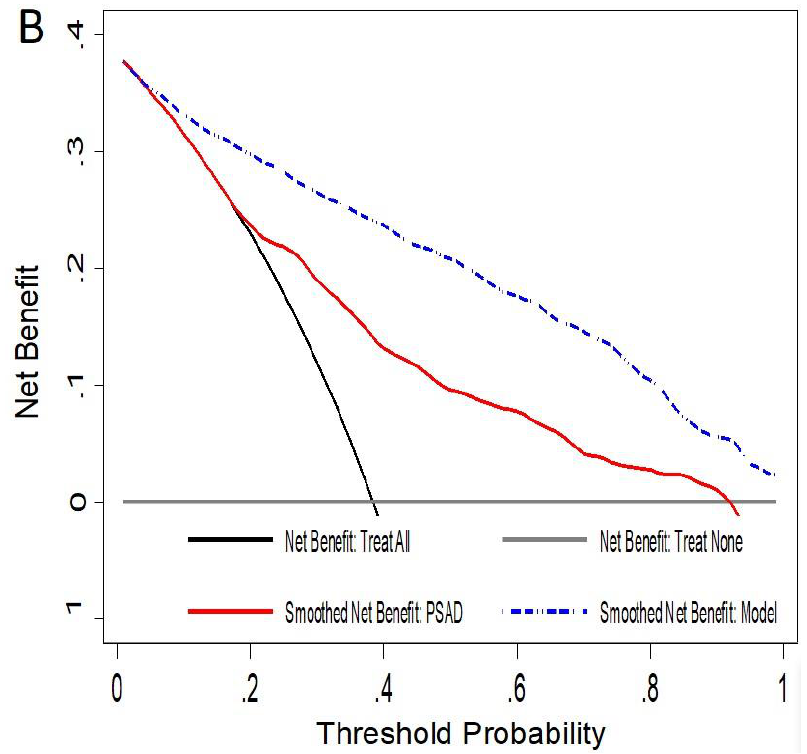
Figure 1. The ROC curves and AUCs show the efficacy of mPSAD (PSAD in the graphic) and MRI- PMbdex (model in the graphic) in detecting csPCa ( A ). The DCAs show the net benefit of mPSAD and MRI-PMbdex compared to performing biopsies on all men according to the csPCa probability threshold ( B ). The thresholds of MRI-PMbdex and mPSAD with 95% sensitivity for csPCa were 13.5% and 0.628 ng/mL 2 , respectively, and their corresponding specificities were 51.1% and 19.6%, respectively, with p < 0.001 (Table 3). MRI-PMbdex and mPSAD were able to avoid 33.4% and 14.0% of prostate biopsies, respectively, while missing 5% of csPCa ( p < 0.001). In relation to the aggressiveness of missed csPCa, both mPSAD and MRI-PMbdex missed 2.4% of PCa with ISUP-GG ≥ 3 (22/934). Furthermore, mPSAD missed 1% of csPCa with ISUP-GG ≥ 4 (9/934), while MRI-PMbdex did not miss any of them. Table 3. Performance of mPSAD and MRI-PMbdex, with respective thresholds of 0.628 ng/mL 2 and 13.5%, in the entire study population and grade groups of detected tumours.